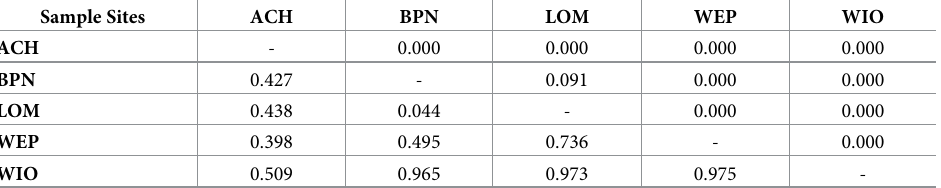
Table 6. Pairwise F ST values (below the diagonal) and P -values (above the diagonal) between the S . lewini popula- tions from Aceh (ACH), Balikpapan (BPN), Lombok (LOM), West Papua (WEP), and Western Indian Ocean